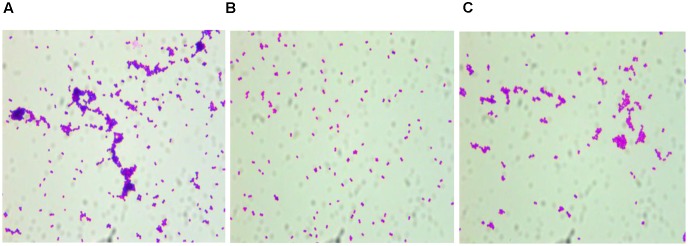
Comparison of aggregation ability of different strains. Photograph were taken by oil immersion lens. (A) wild type (RP62A), (B) the sesI mutant strain, (C) the complement strain.